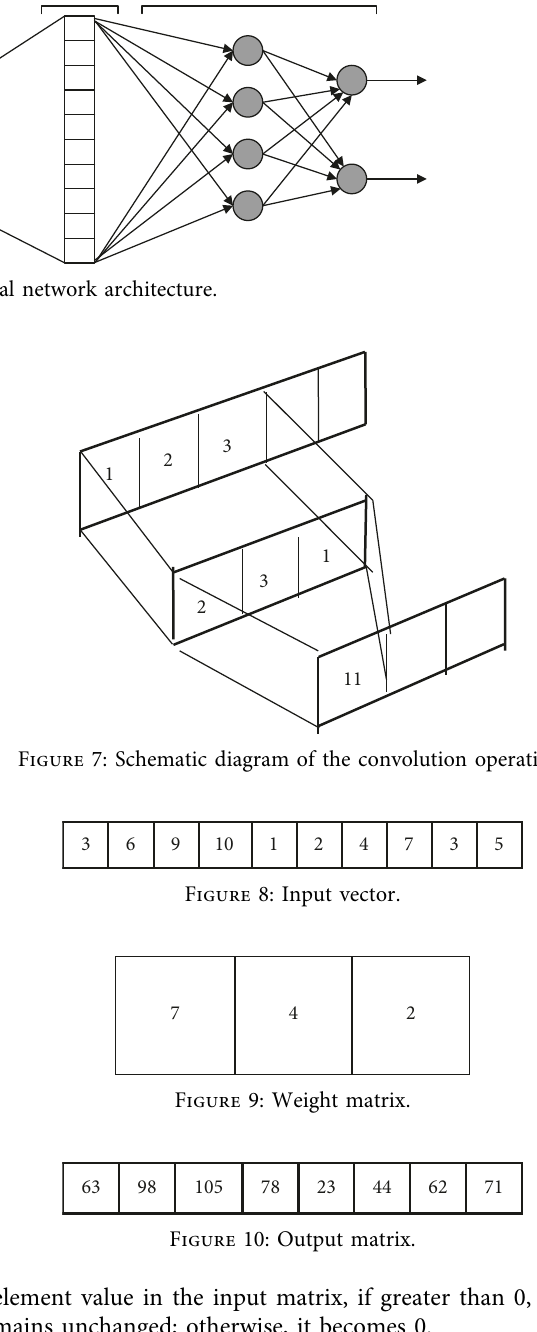
Figure 9: Weight matrix.